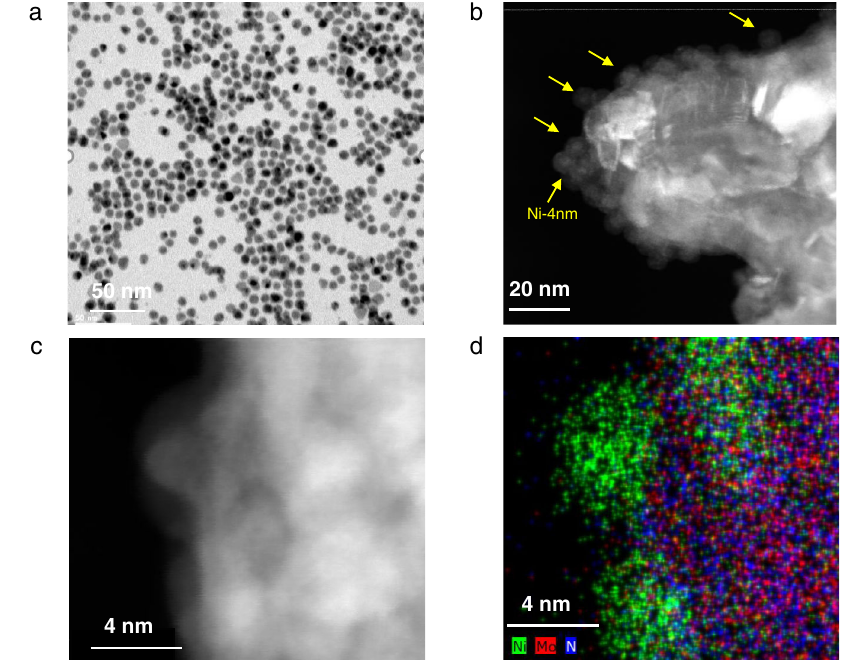
Fig. 2 The electron microscope images of the fresh Ni-4nm/ γ -Mo 2 N catalyst. a TEM image of the Ni-4nm suspension precursor; b , c STEM images of fresh Ni-4nm/ γ -Mo 2 N catalyst; d The EDS element mapping of fresh Ni-4nm/ γ -Mo 2 N catalyst, Ni green, Mo red, N blue.